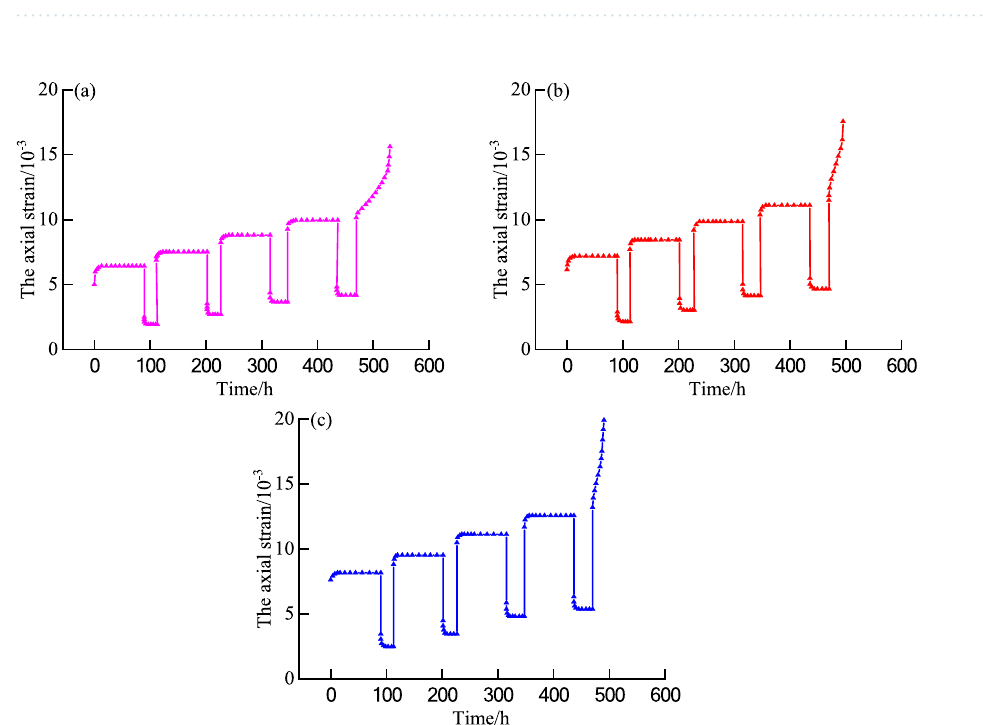
Figure 1. Sandstone creep curve under step loading and unloading conditions. (a) 4 MPa, (b) 8 MPa, (c) 12